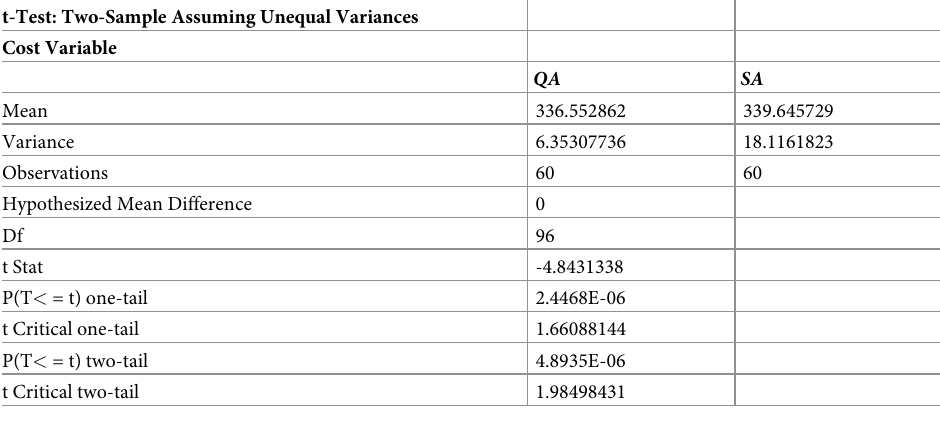
Table 16. T-test for n = 20 nodes and N = 60 trials–total distance cost variable. t-Test: Two-Sample Assuming Unequal Variances